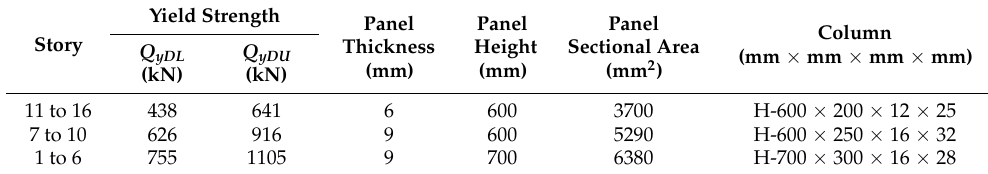
Table A4. Steel damper columns for 16-story